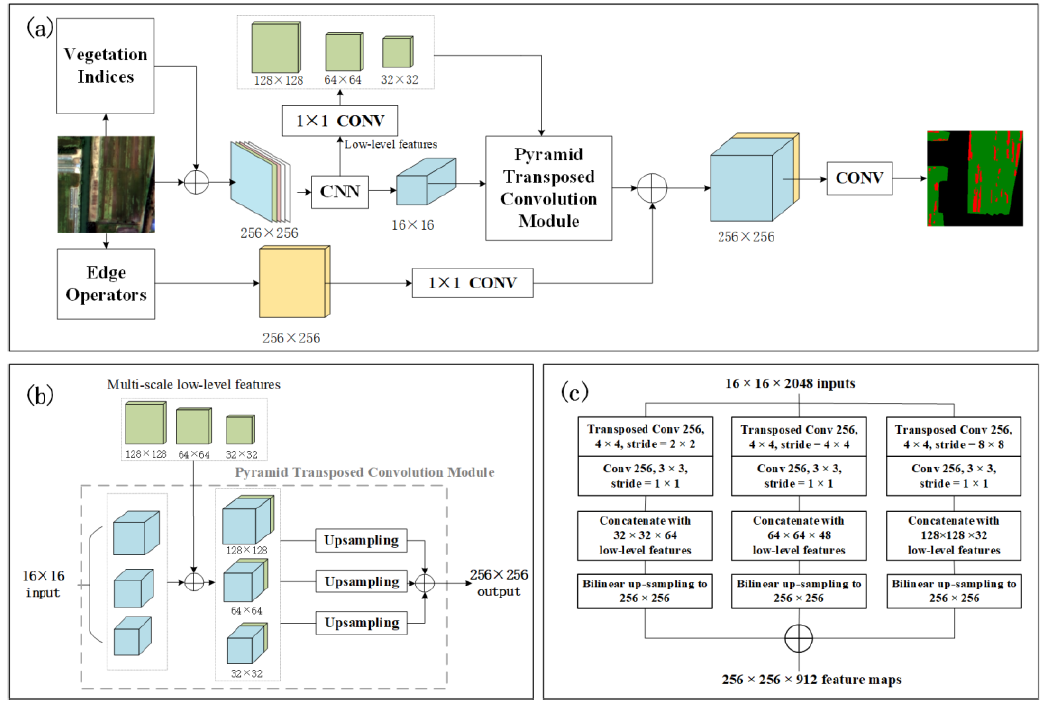
Figure 6. PTCNet architecture: ( a ) model structure of PTCNet; ( b ) structure of PTC module; ( c ) workflow of PTC module.